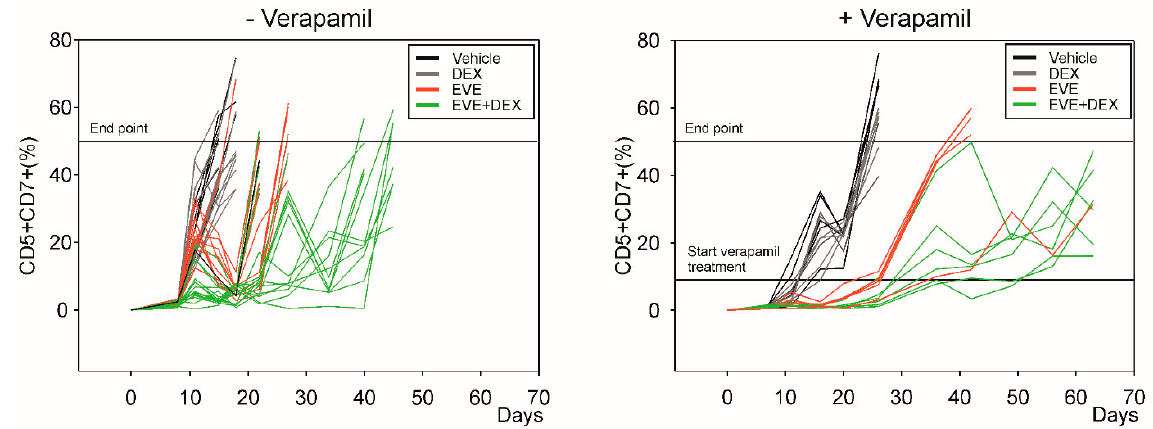
Figure 6. In vivo experiments with everolimus, dexamethasone, and verapamil. The 1 × 10 6 PDX19 cells were injected in the tail vein of 24 NOD/SCID mice. After one week, the mice were treated every second day with either a drug vehicle (black lines), dexamethasone (15 mg/kg, grey lines), everolimus (4 mg/kg, red lines), or dexamethasone (15 mg/kg) plus everolimus (4 mg/kg) (green lines). The effects of drug treatments were assessed by measuring the percentages of CD5+/CD7+ PDX cells in total PBMC in the absence ( left -hand graph) or presence ( right -hand graph) of verapamil (20 mg/kg), which was added to the drug treatment regimen when the population of leukemic cells reached >10% (indicated by the lower horizontal line in the right-hand graph). Lines indicate individual mice.